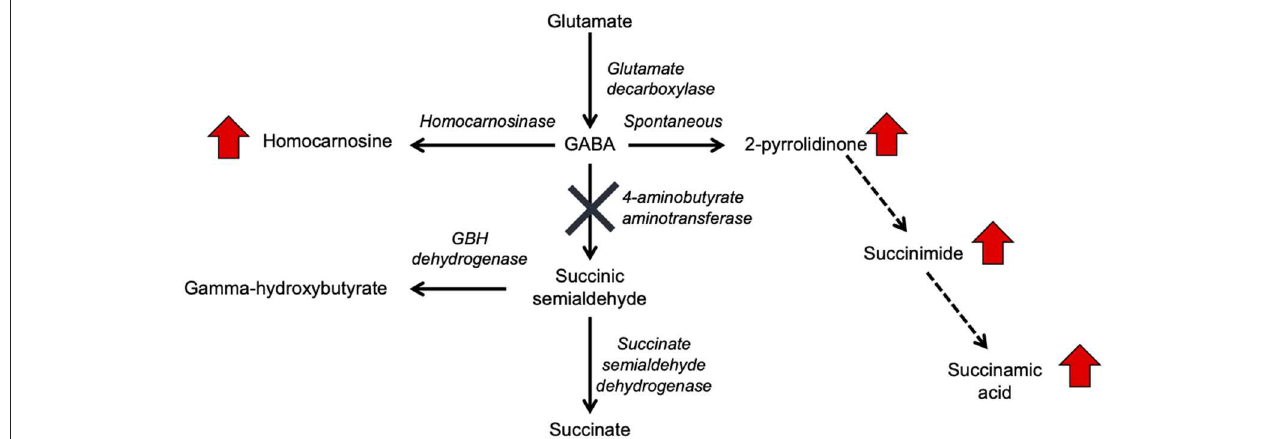
FIGURE 1 | GABA metabolism pathways are altered due to GABA-transaminase deficiency and treatment affecting GABA metabolism. The entire pathway from glutamate conversion to GABA through succinate formation is represented along with the respective enzymes for each step. Due to tissue-specific expression of the enzymes, not all molecules are detected in each biological matrix (e.g., homocarnosine is present below the limit of detection in plasma).